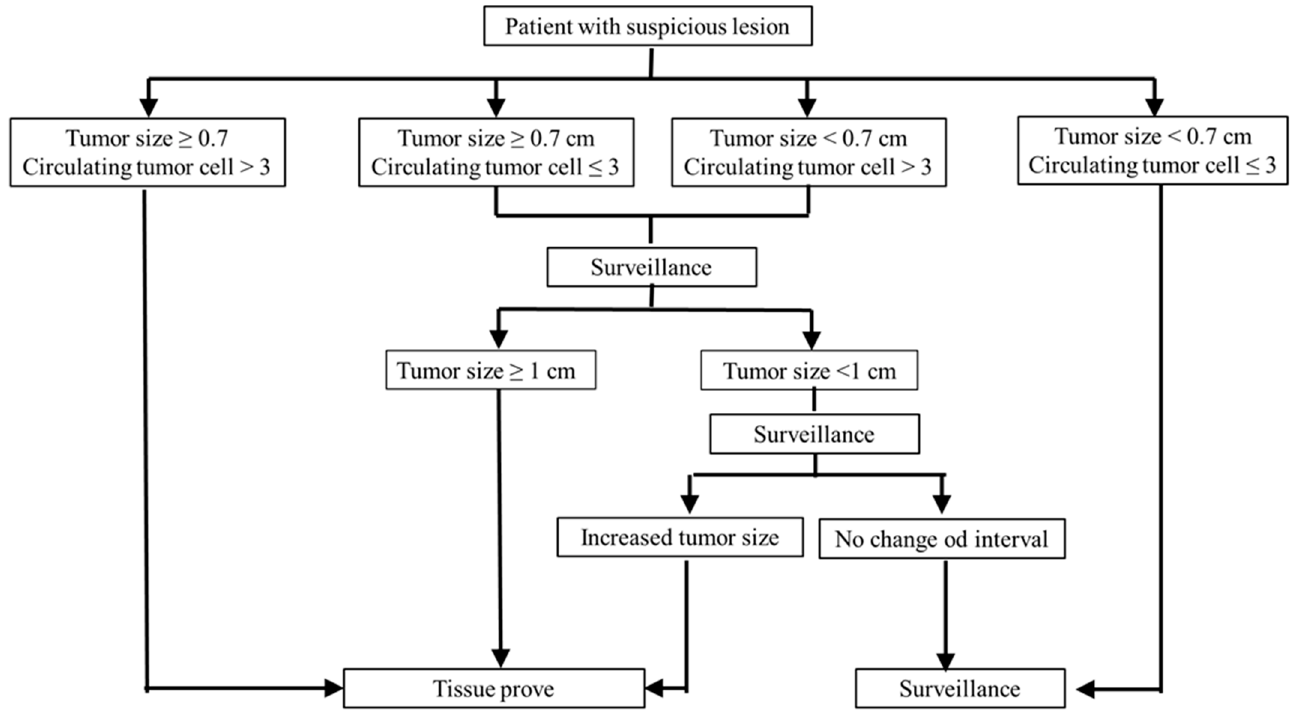
Figure 2. Recommended patient management algorithm based on tumor size and CTC.